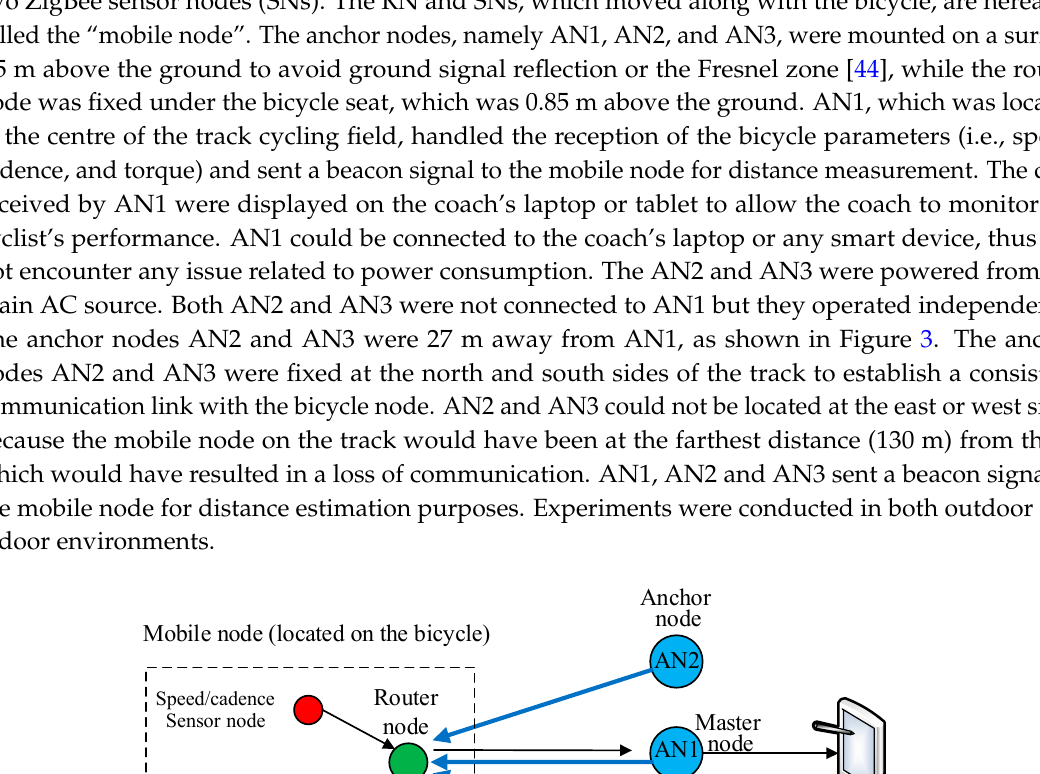
Sensors 2016 , 16 , 1043